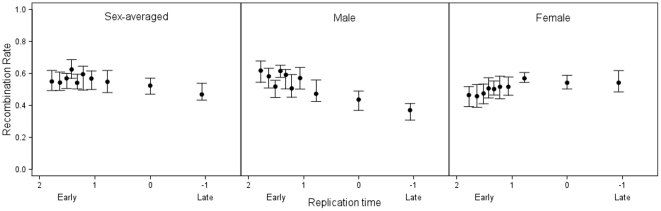
Sex-specific relationships between replication time and recombination rate.Relationships between replication time and sex-averaged, male-specific and female-specific recombination rates. Data shown are mean-smoothed2 data binned by median replication time where points are the median of each equally sized bin ± 95% confidence intervals.